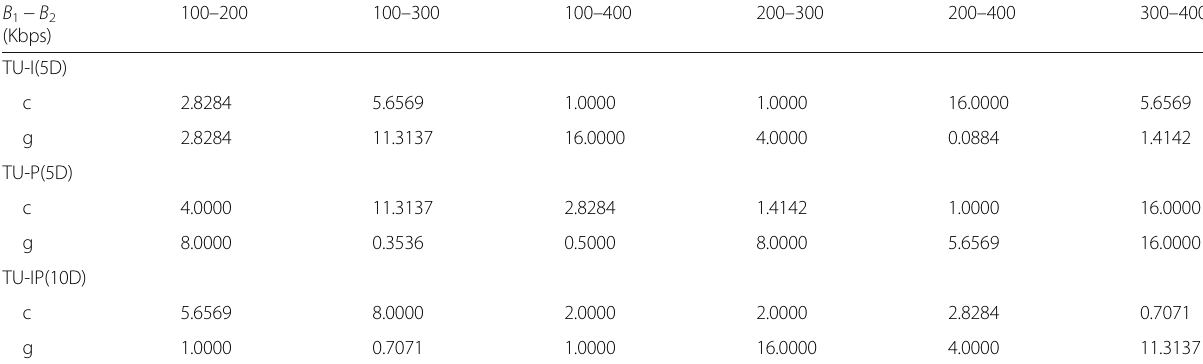
Table 3 The parameters used for training libSVM for feature set TU-I, TU-P, and TU-IP on QCIF video dataset